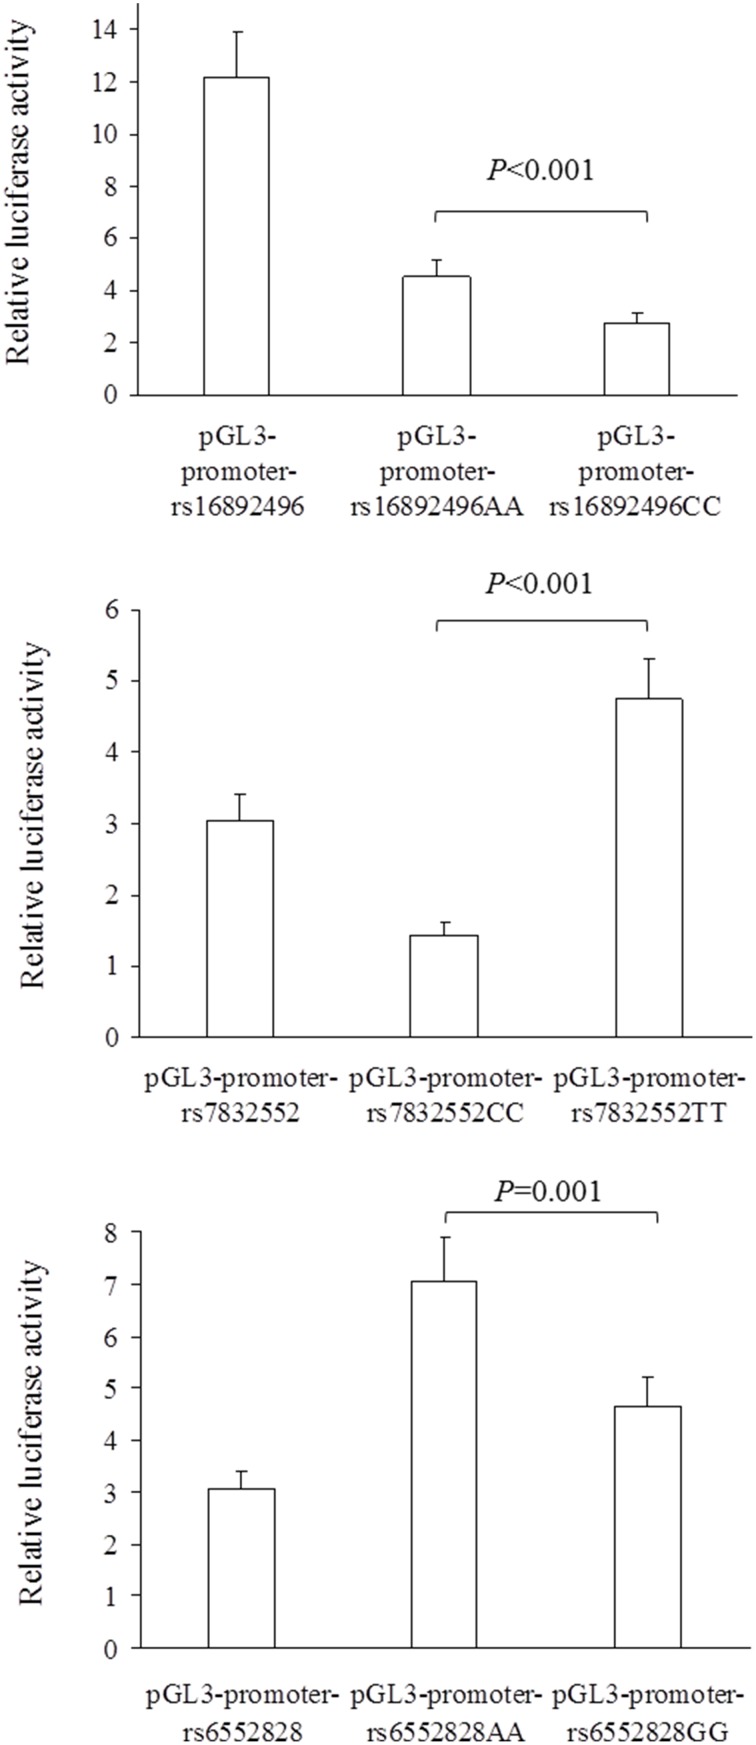
Comparison of relative luciferase activity (i.e., firefly luciferase activity divided by renilla luciferase activity) between plasmids for the THRH rs16892496 (upper panel), THRH rs7832552 (middle panel), and ACSL1 rs6552828 (lower panel). Values are mean ± SD of three different experiments, each performed in triplicate. For the 3 SNPs, statistical significance was reached for all the comparisons between plasmids (all P ≤ 0.001).